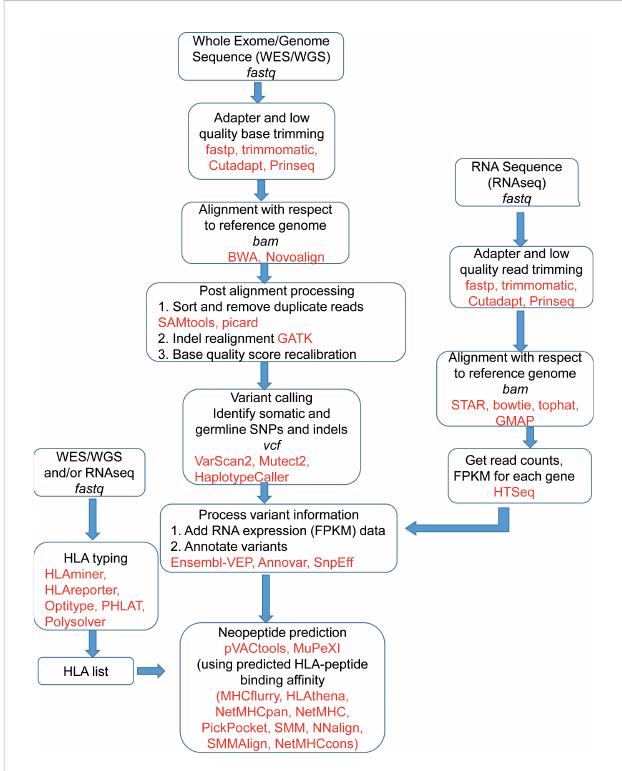
FIGURE 2 A schematic of the bioinformatics process of neoantigen vaccine design. Frequently used software and tools are in red. The fi le formats are in